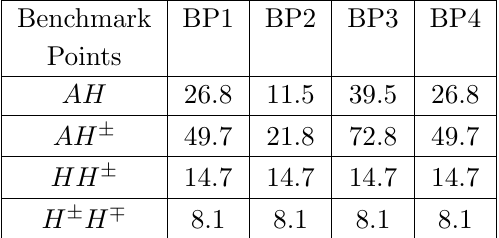
p ^ s as renormalization and factorization